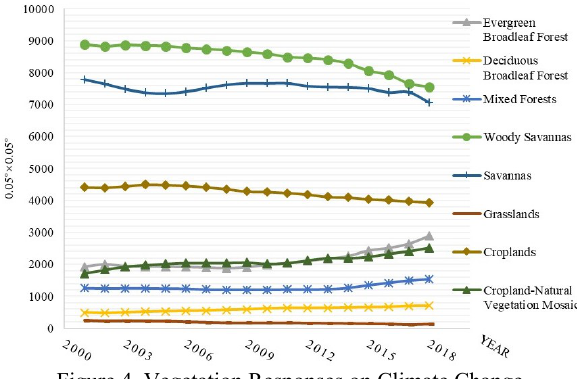
Figure 4. Vegetation Responses on Climate Change